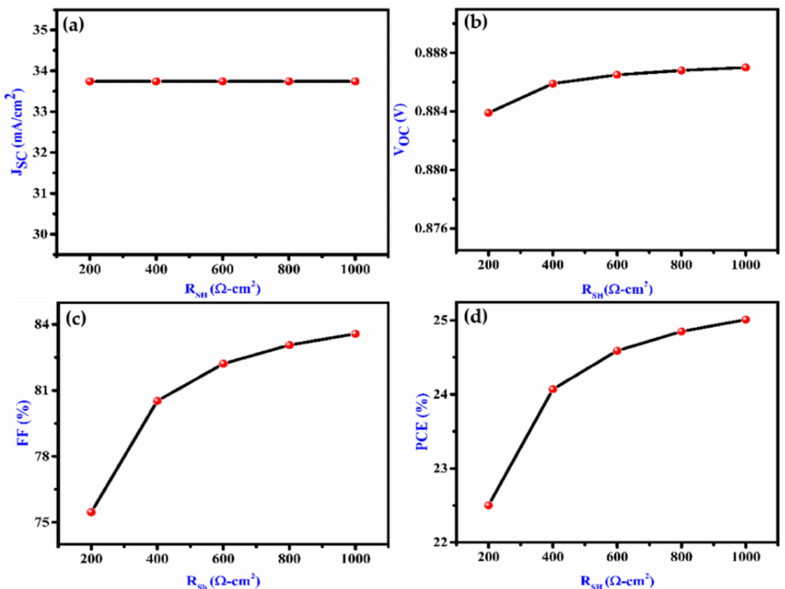
Figure 6. Effect on ( a ) J SC , ( b ) V OC, ( c ) FF and ( d ) PCE with variation of shunt resistance of the proposed